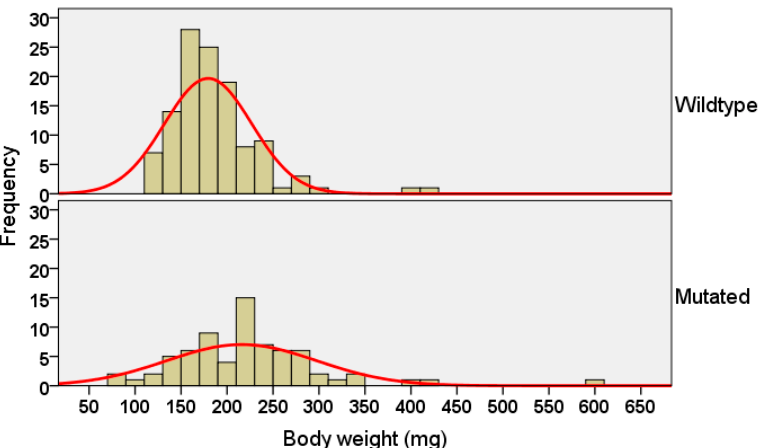
Figure 7. Distribution of body weights of melanocortin-4 receptor ( mc4r )-mutated Kansas random channel catfish, Ictalurus punctatus , at 30 days post fertilization (dpf) compared with full-sib control fish. The fry were reared in fry catchers in a flow-through system and fed Artemia nauplii for one week post fertilization, followed by Purina ® AquaMax ® Fry Powder. The mean body weight of the mc4r -mutated fry was higher than the control fry (independent t -test, p = 0.001).